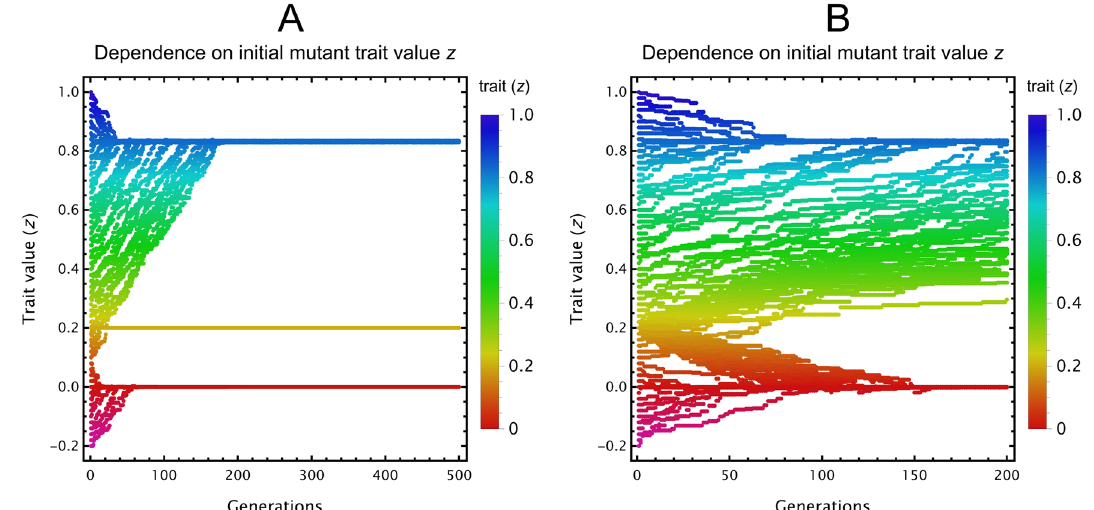
Figure 4. Evolutionary trajectories of resident and mutant cross-feeding species with inhibition, throughout successive generations of invasions in case only one ( A ) or both species can mutate ( B ). Adaptive dynamics simulations start from different initial mutant trait values ( z ). Trait value (y-axis) is shown against generations (x-axis) for both mutant classes. Colours correspond to trait value, opacity to the relative equilibrium density of the various species present in the actual population. ( A ) Only species 2 can mutate, species 1 is fixed (orange line at z 1 = 0.2 ). Evolutionary trajectories of species 2 converge to either the equilibrium trait value at around z ≈ 0.82 (in case the starting trait is larger than about 0.1), or to the one at z = 0 . ( B ) Both species may evolve. To achieve mutually positive trait values (implying cross- feeding), species 1 must have a starting trait over 0.2. Trajectories starting from around this critical z ≈ 0.2 may end up at either equilibrium due to stochasticity. When both species have positive equilibrium trait values, mutual cross-feeding evolves. In case one (or both) species converge to z = 0 , there is no cross- feeding as the trait value defines low mortality with negligible cross-feeding efficiency. Parameters are